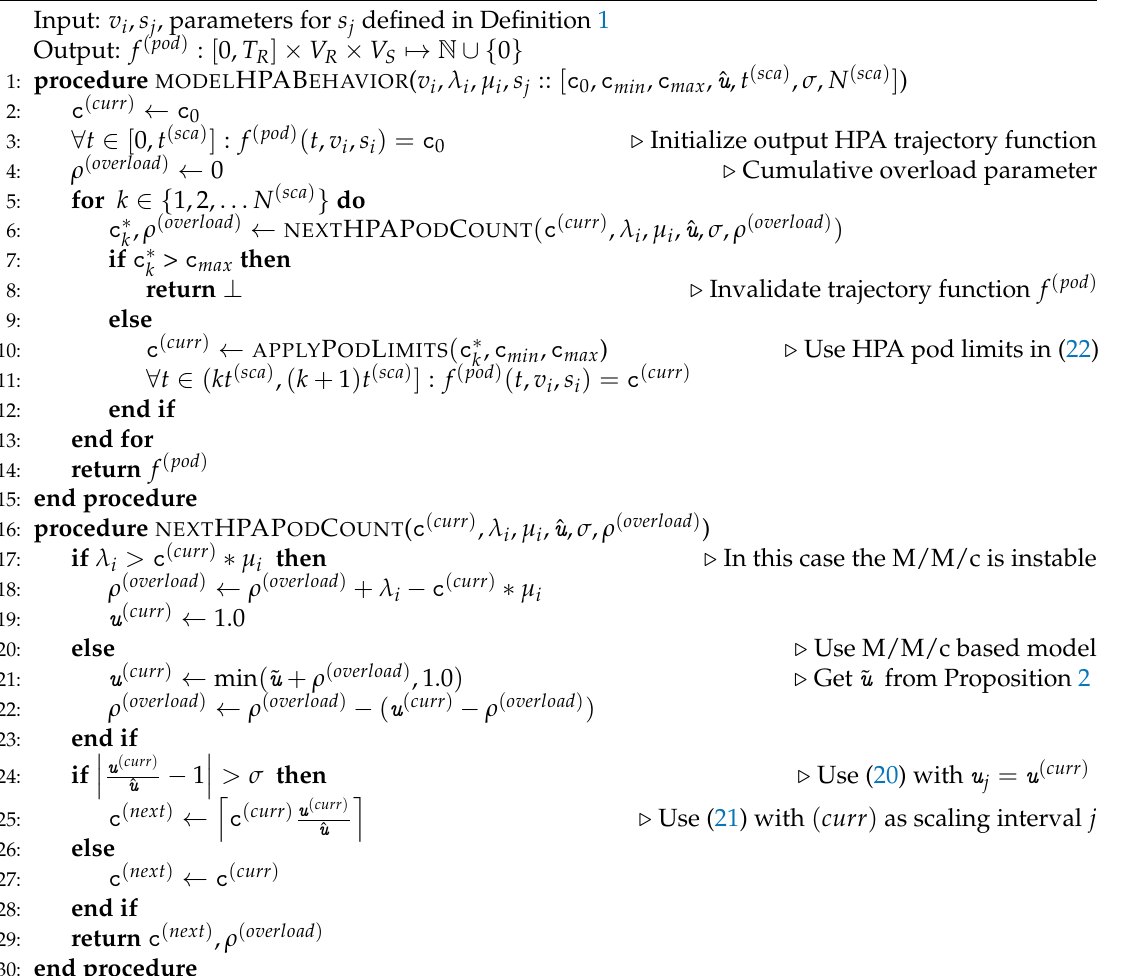
Algorithm 3 Pod count trajectory modeling of Kubernetes